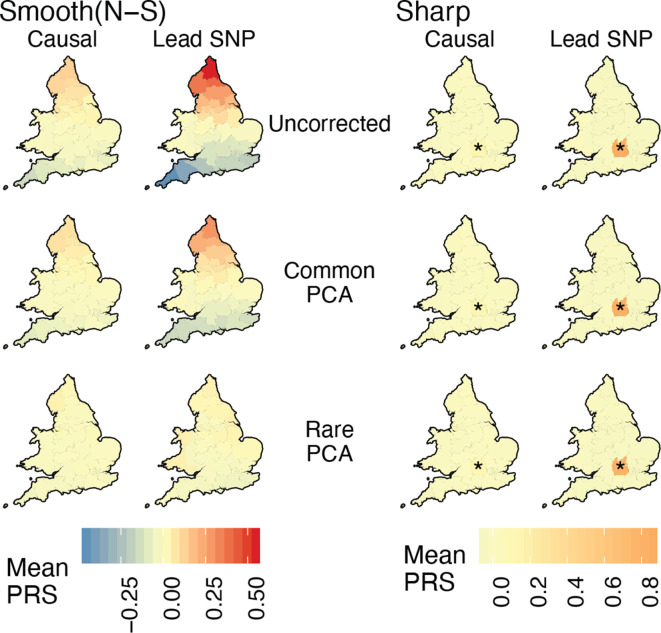
Spatial distribution of residual polygenic scores under the ‘complex’ structure model when individuals are sampled uniformly across demes.Each region is colored with the mean residual polygenic score across 250 individuals and 20 random iterations. ‘Smooth’ refers to a North-South environmental risk and ‘Sharp’ refers to a local environmental risk (risk location indicated with *). Polygenic scores were constructed using either the true causal variants (Causal) or the topmost significant SNPs (Lead SNPs). Compare this to Figure 5 where individuals are sampled non-uniformly.